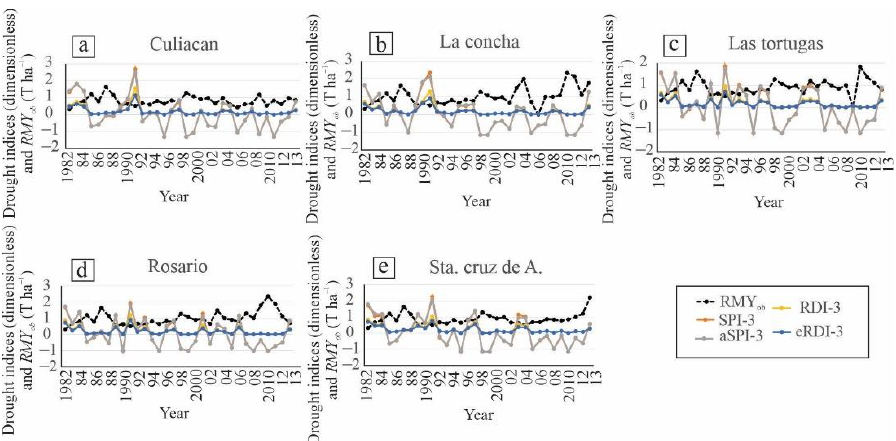
Figure 2. Annual variation (dimensionless) of the SPI-3 , aSPI-3 , RDI-3 and eRDI-3 , and RMS ob indices (T ha — 1 ). The black line refers to RMY ob and the four meteorological drought indices in Sinaloa are shown in red ( SPI-3 ), gray ( aSPI-3 ), yellow ( RDI-3 ) and blue ( eRDI-3 ) (Figures 2a-2e).